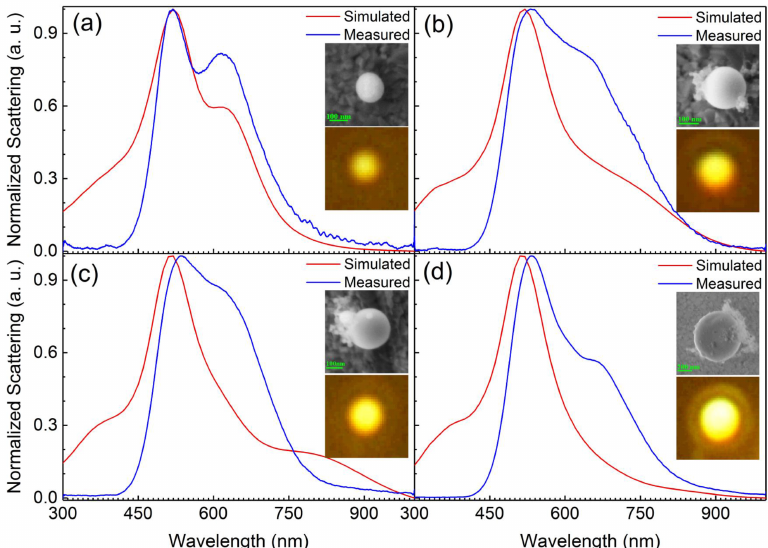
Figure 3. Measured scattering spectra for Ga NPs with different diameters. ( a ) d = 165 ± 2 nm, ( b ) d = 220 ± 2 nm, ( c ) d = 264 ± 2 nm and ( d ) d = 657 ± 2 nm. In each case, the SEM images of the Ga NPs and the corresponding radiation patterns are shown as insets. The size of the optical images is 4 × 4 µ m 2 . The simulated scattering spectra are also provided for comparison. All the scattering spectra were normalized in order to compare the spectral